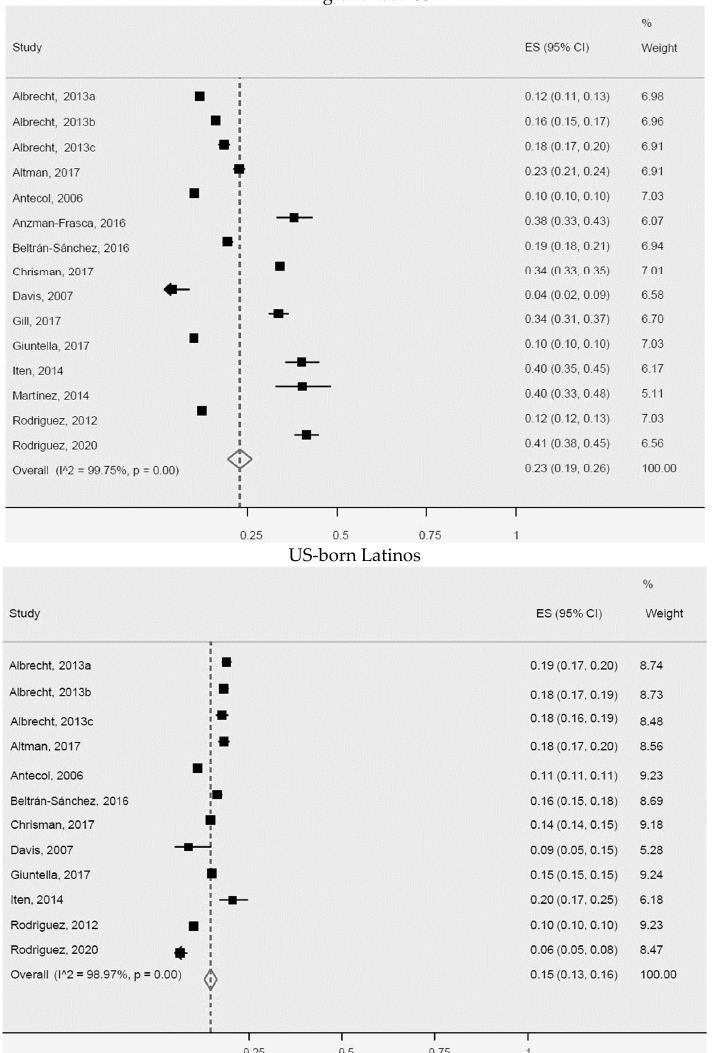
Figure 8. General obesity for immigrant Latinos and US-born Latinos. ES = Estimated propor- tion/prevalence; CI = Confidence interval; I^2 = I 2 index. HDL Cholesterol and Triglycerides for Latinos in the US All studies that determined HDL cholesterol HDL (7) and triglycerides (7) collected data through blood workups. Five studies were included in the meta ‐ analysis of the prevalence of low HDL cholesterol in Latinos (Figure 9), revealing a prevalence of 42%